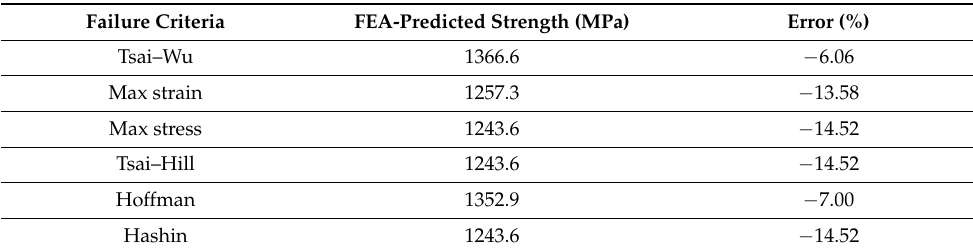
Table 7. Summary of results from different failure criteria—Toray